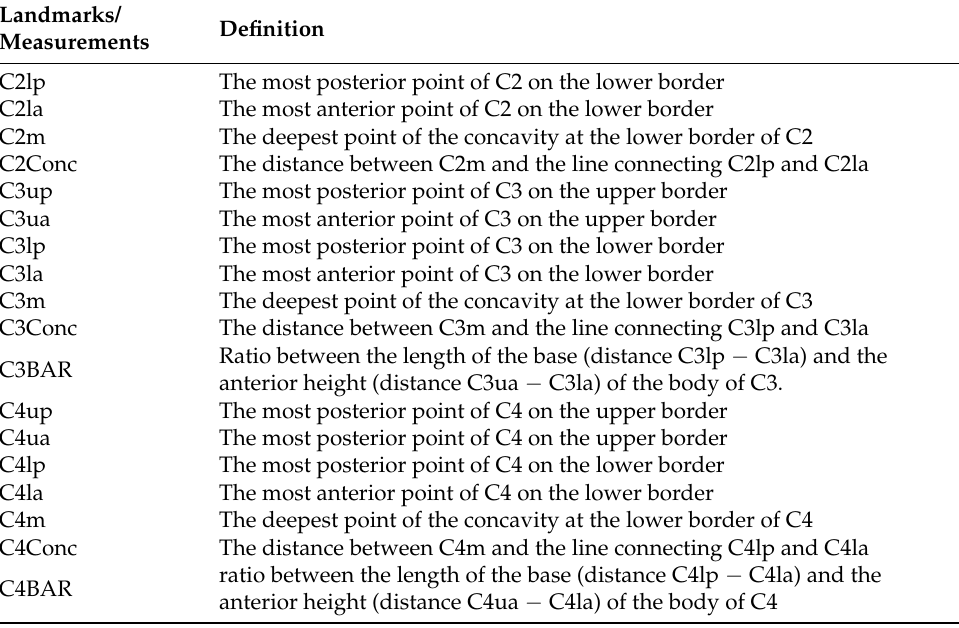
Figure 2. Schematic representation of anatomic landmarks and liner measurements for the determi- nation of cervical vertebral morphology. ( A ) Two reference points (R1 and R2) and thirteen anatomic landmarks of C2, C3 and C4. The distance between the two reference points (R1 and R2) is 10 mm. ( B ) C2Conc = C2m − C2m (cid:48) . ( C ) C3Conc = C3m − C3m (cid:48) . ( D ) C3BAR = (C3lp − C3la)/(C3ua − C3la). ( E ) C4Conc = C4m − C4m (cid:48) . ( F ) C4BAR = (C4lp − C4la)/(C4ua − C4la). Table 2. Landmarks and measurements used to determine cervical vertebral